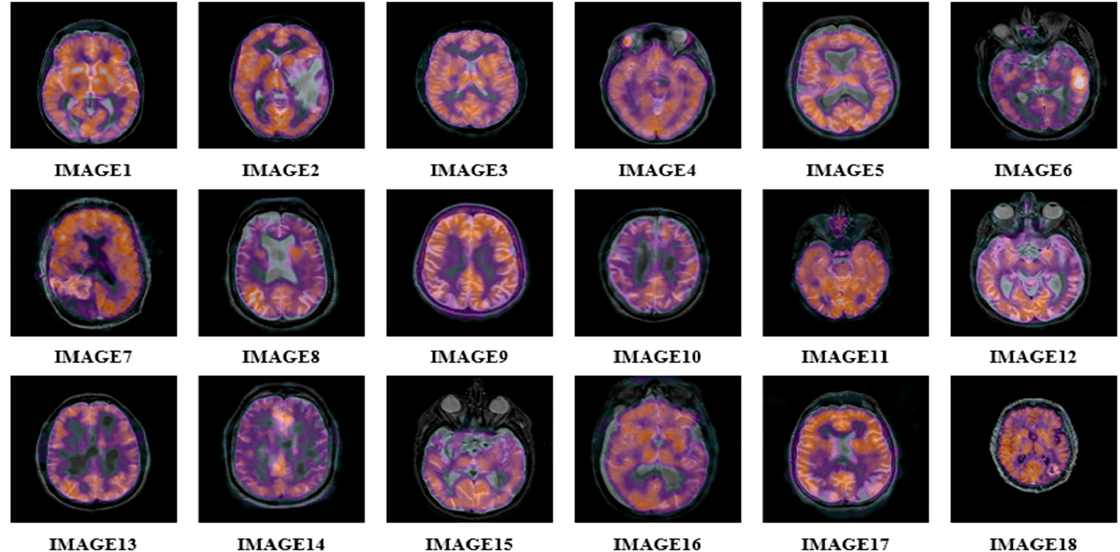
Figure 3. Original MRI color medical images.